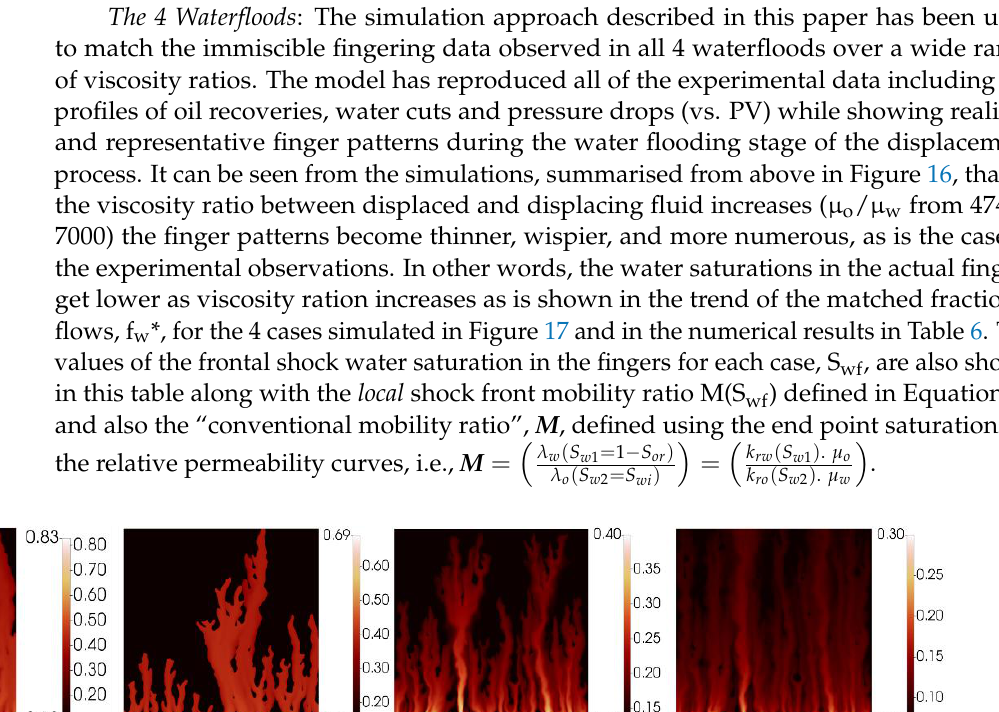
Figure 15. Relative permeabilities ( left ) and fractional flow & total mobility ( right ) for the displace- ment of 412 mPa.s and 616 mPa.s oil.